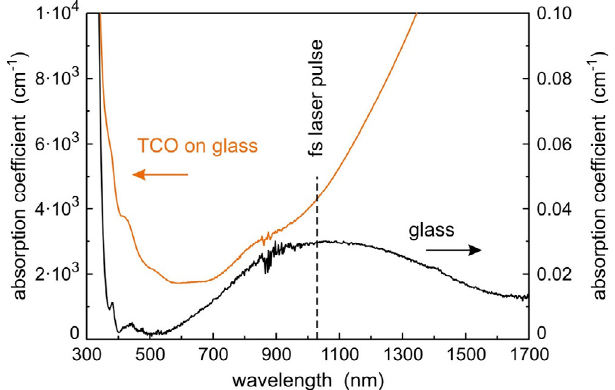
Fig. 1. Absorbance of an ITO/glass sample (orange curve) and a pure glass substrate (black curve); the laser wavelength is indicated by a vertical dashed